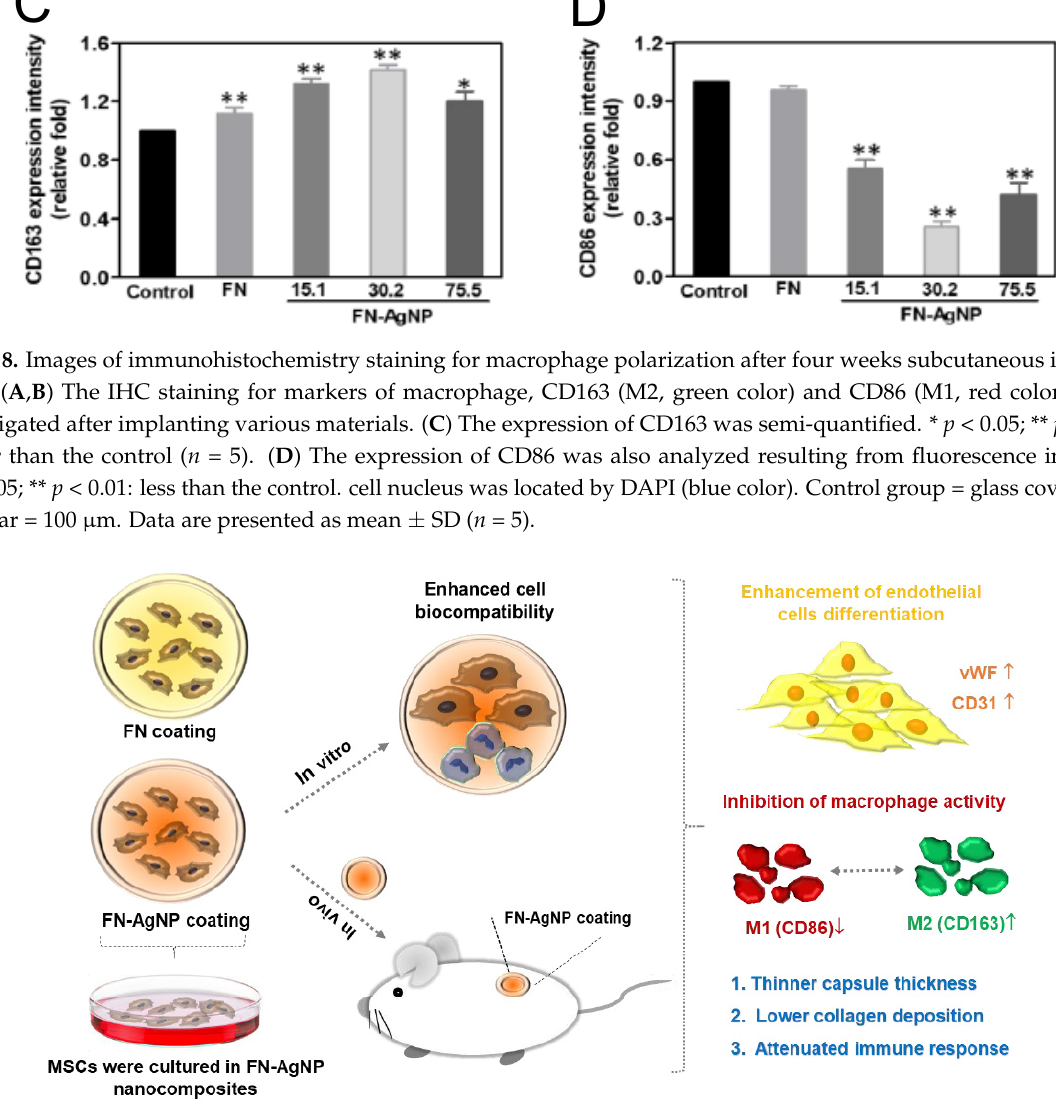
Figure 9. Schematic illustrations that indicate the efficacy of FN-AgNP nanocomposites. FN-AgNP nanocomposite coating enhanced the migration and differentiation ability of MSCs while inhibiting monocyte activation. Furthermore, after im-planted into the rat model, FN-AgNP induced thinner capsule formation, lower collagen deposition, and had an anti-immune response. Based on these evidences, FN-AgNP nanocomposites are suggested to be a promising surface modifi-cation strategy for biomedical applications.